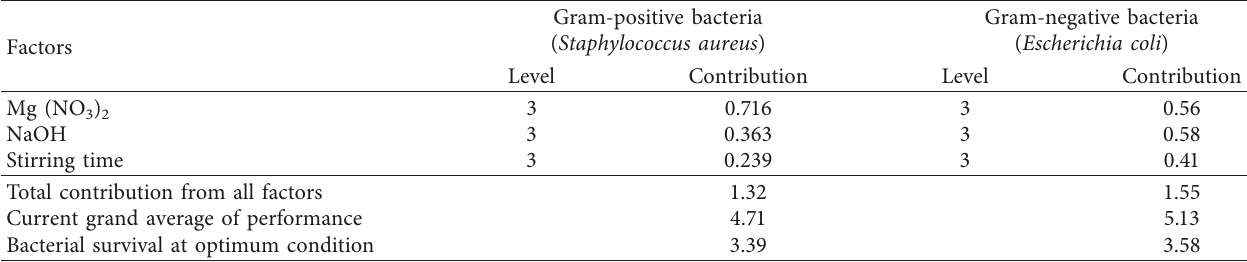
Table 5: Predicted the optimal conditions for producing MgO nanoparticles with the greatest antibacterial activity.